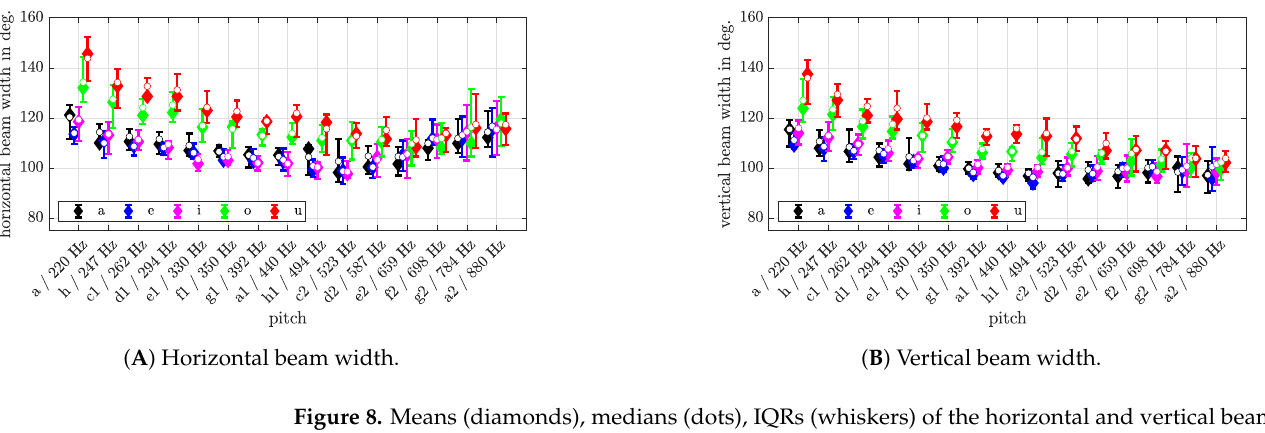
Figure 8. Means (diamonds), medians (dots), IQRs (whiskers) of the horizontal and vertical beam width in degree over pitch for the female singers for the five vowels and all phonation modes.